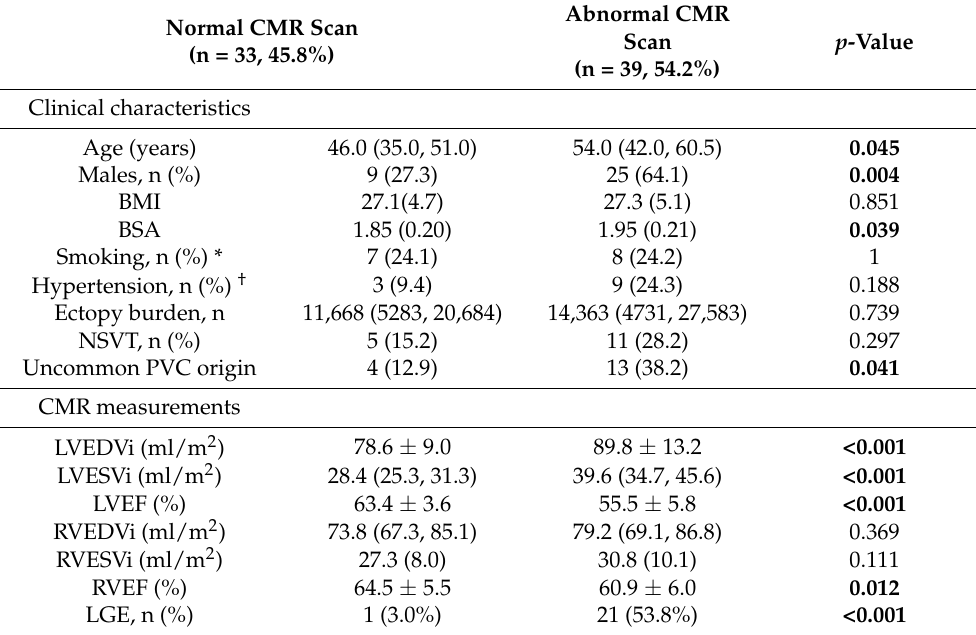
Abnormal CMR p -Value Scan (n = 39, 54.2%)